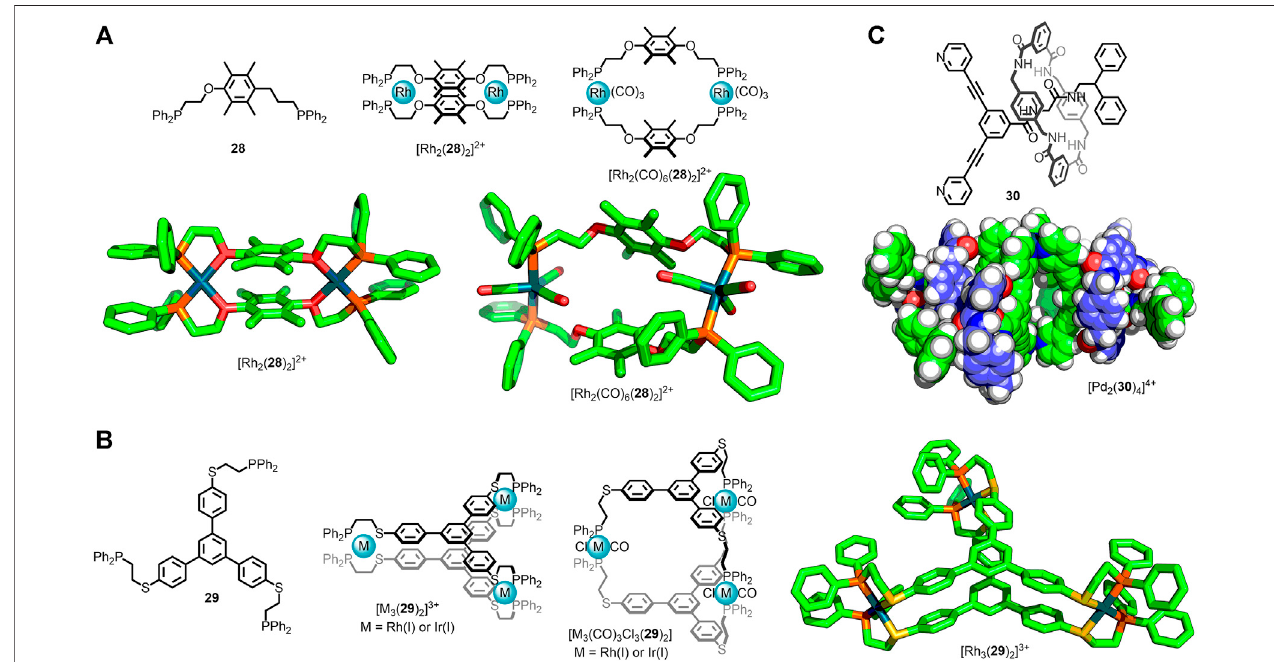
FIGURE 4 | (A) Mirkin ’ s Weak-Link Approach in which a rigid metallacycle precursor, [Rh 2 ( 28 ) 2 ] 2+ , is fi rst formed under thermodynamic control. Subsequent displacementoftheetheroxygendonorsgavethe fl exiblemetallacycle[Rh 2 (CO) 6 ( 28 ) 2 ] 2+ ,withligand 28 coordinatedinabis-monodentatefashion. (B) Thisprinciplehas beenappliedtoMOCs,with fl exiblecage[M 3 (CO) 3 Cl 3 ( 29 ) 2 ]accessed via thermodynamicintermediate[M 3 ( 29 ) 2 ] 3+ [M (cid:2) Rh(I)orIr(I)]. (C) Lewis ’ [2]rotaxaneligand, 30 ,that self-assembled with Pd(II) ions to form a Pd 2 L 4 cage (molecular model) with dynamic interlocked macrocycle components (shown in blue).